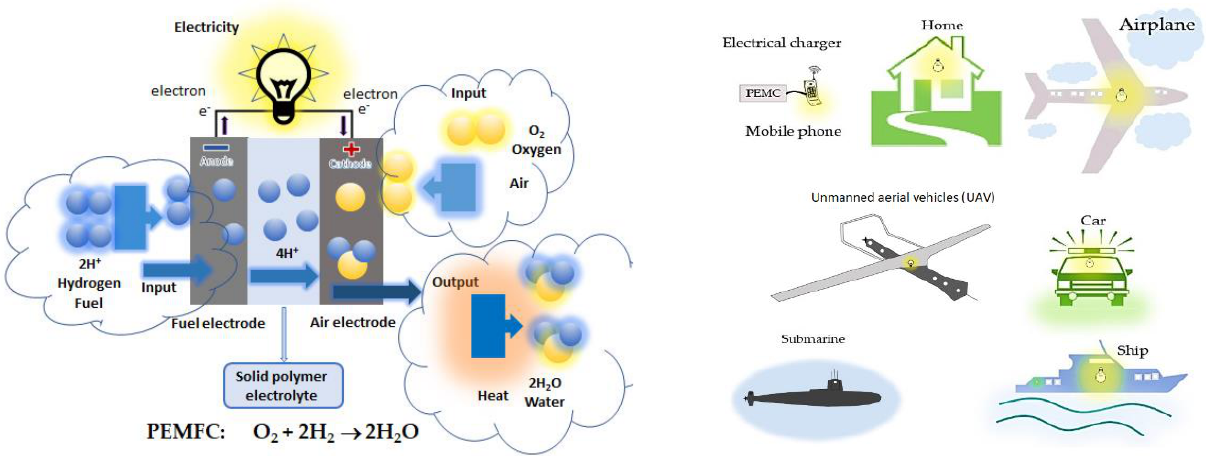
Figure 1. Operation of PEMFCs, and promisingly potential applications for electrical charger in mobile phones, FC cars, FC boats, FC ships, FC airplanes, FC homes and offices, and FC plants in integration with electricity from electric power sources, batteries, and